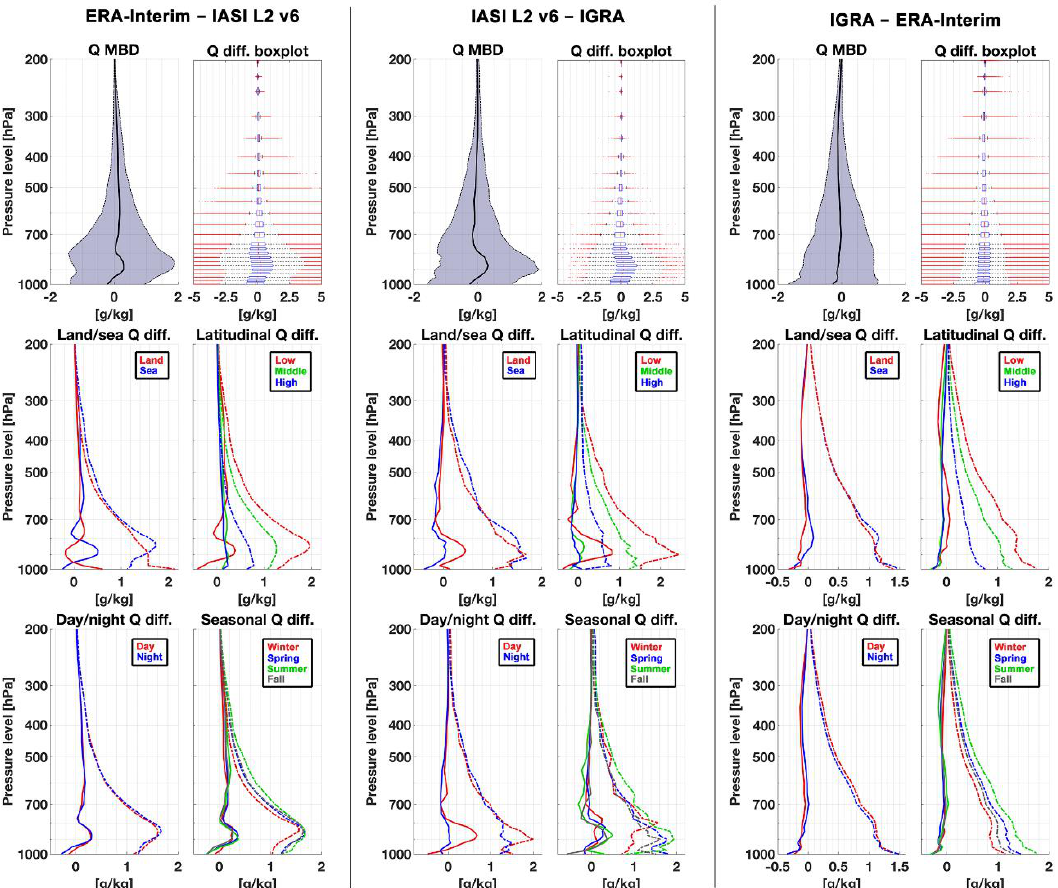
Figure A3. ERA-Interim, IASI L2 v6, and IGRA Q intercomparisons. Top panels show MBD (solid) with standard deviations (dashed area) and the boxplot of the differences. The panels of the second and third rows show MBD (solid lines) and RMSD (dashed lines) of the differences for land/sea surface, high/middle/low latitude, daytime/nighttime, and for the four seasons. ERA-Interim–IASI L2 v6, IASI L2 v6–IGRA, and IGRA–ERA-Interim are shown by the left, center, and right panels, respectively.